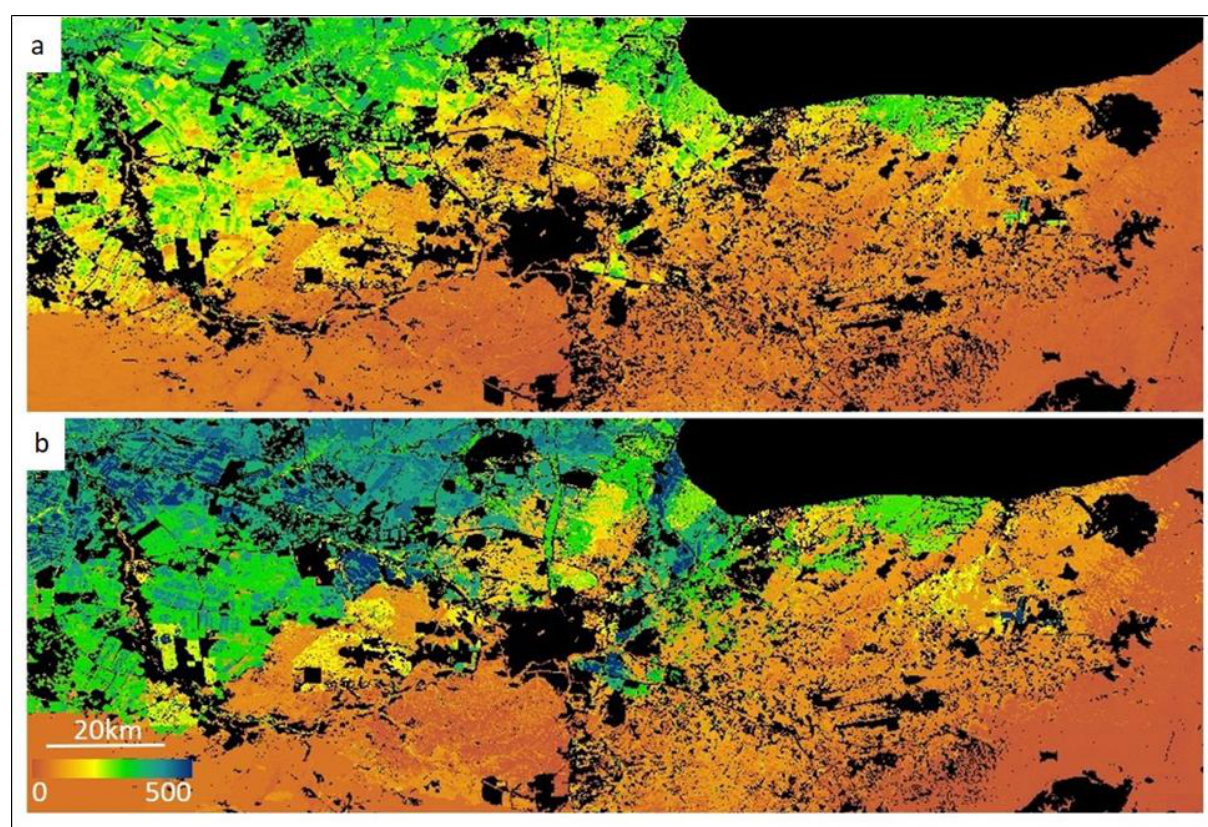
Figure 3. Primary production (NPP) of the study area calculated from Landsat data. ( a ) Observed NPP (NPP obs ); ( b ) potential NPP (NPP pot ). Means for 2001–2010 and 2012 in gCm −2 yr −1 . The difference between NPP obs and NPP pot is shown in Figure 4.